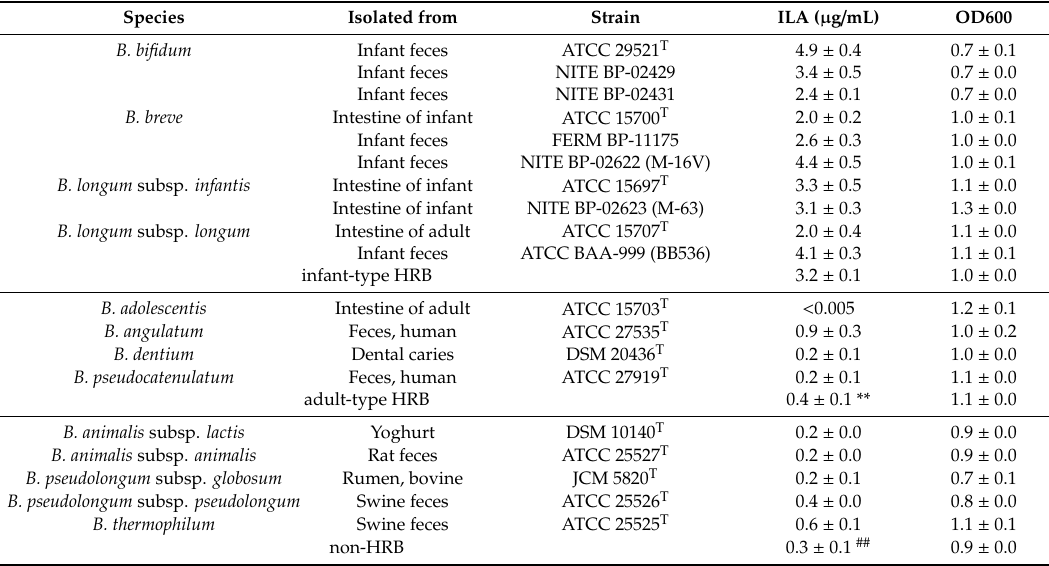
Table 1. Production of Indole-3-Lactic Acid (ILA) by 19 Bifidobacterial